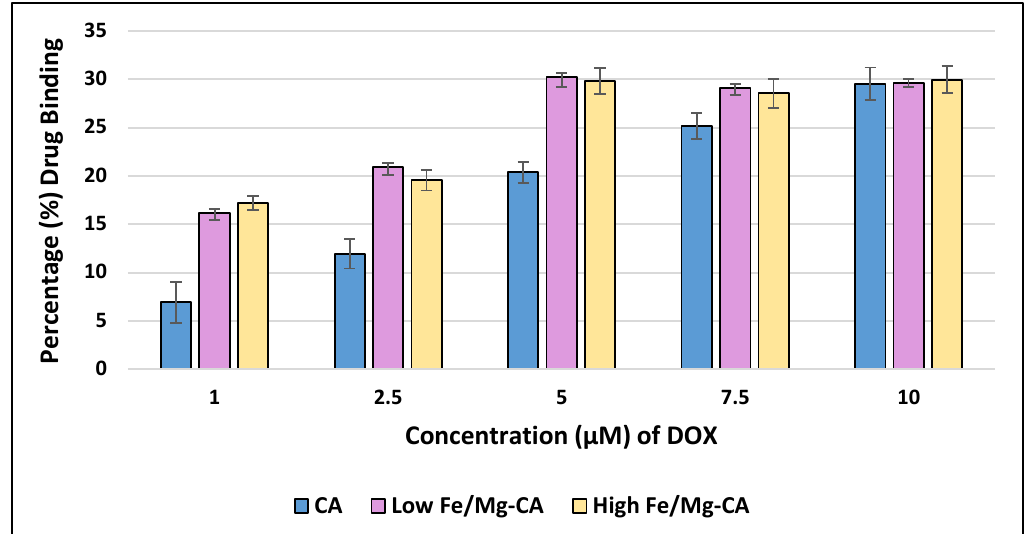
Figure 9. Estimation of binding affinity of doxorubicin (DOX) for CA, low Fe/Mg-CA and high Fe/Mg-CA NPs with increasing concentrations of DOX (1, 2.5, 5, 7.5 and 10 μM).